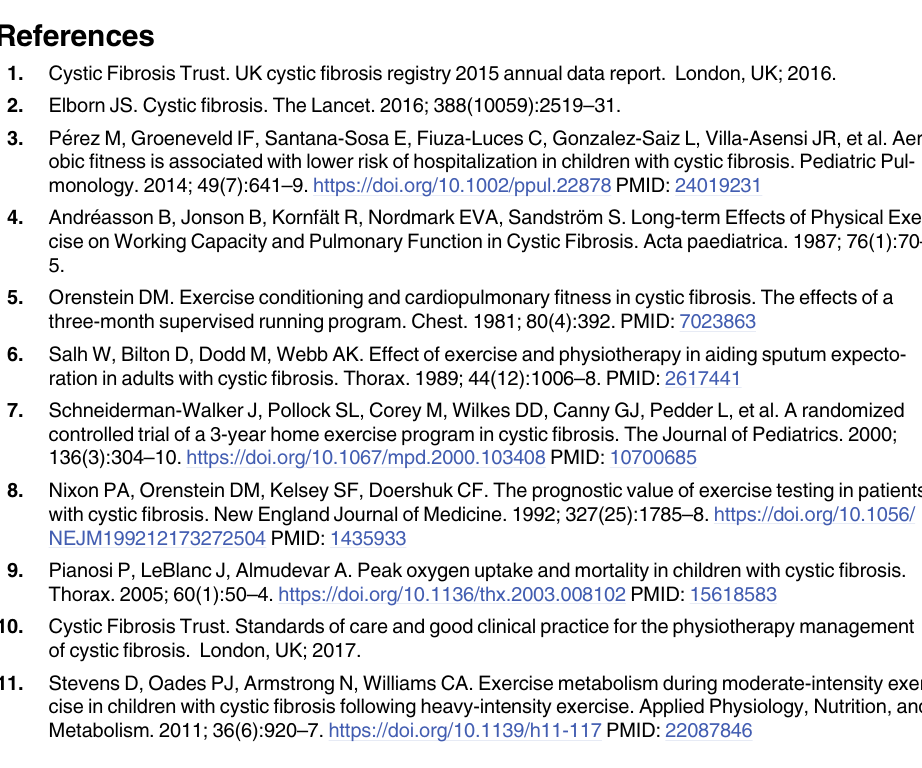
and a for the linear model of D B